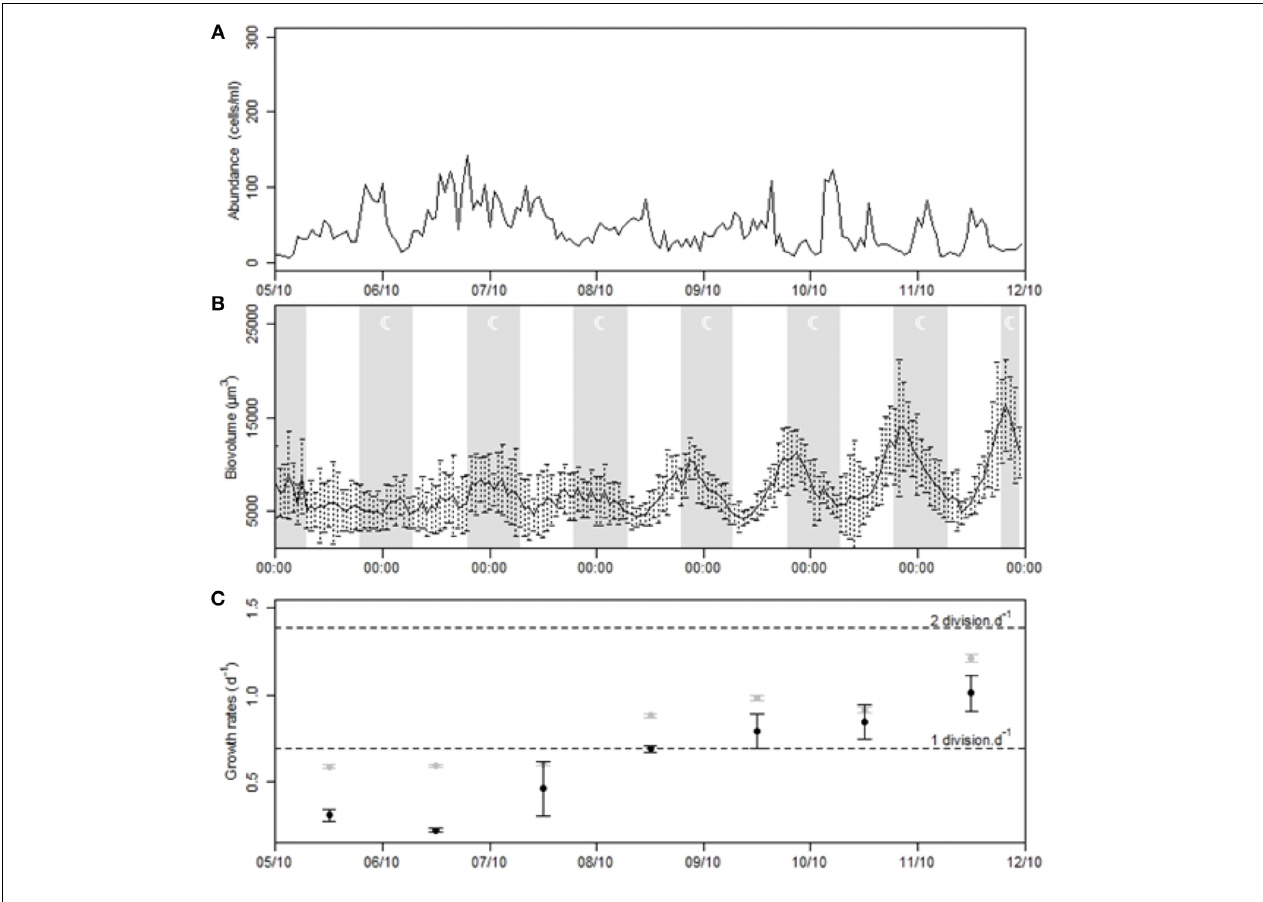
FIGURE 10 | Time series of the Gymnodinium cluster during the strong Mistral event. (A) Population dynamics. (B) Variation of the mean cells biovolume. (C) Estimations of the in situ growth rate provided by the ratio